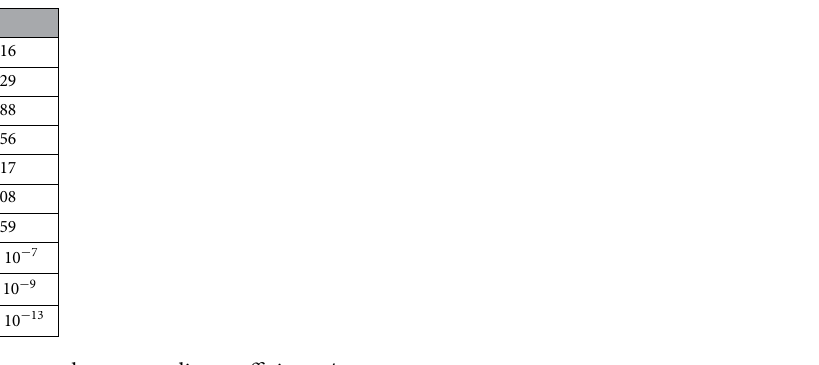
Table 1. Arguments x k and corresponding coefficients A k .